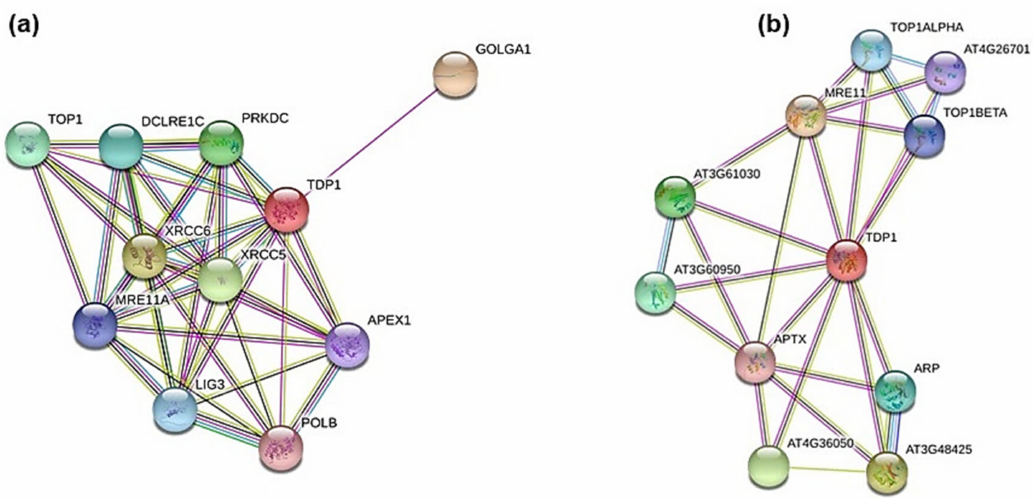
Figure 3. Putative protein-protein interactors of human ( a ) and Arabidopsis thaliana ( b ) Tyrosyl-DNA phosphodiesterase 1 (TDP1) as revealed by the STRING software